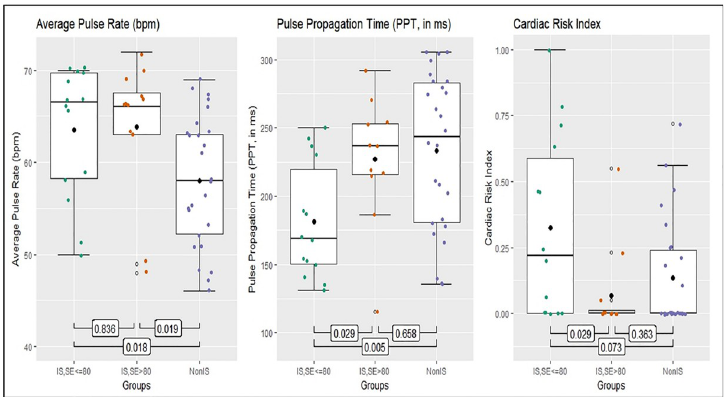
Fig 1. Pulse wave analysis parameters with group differences. IS, insomnia; SE, sleep efficiency. The boxes represent the interquartile range with the median, whiskers represent range of minimum and maximum value. Values outside are outliers of more than 3x interquartile range. p -values for group comparisons, performed with Mann-Whitney U test. Significant values on 0.05 level.